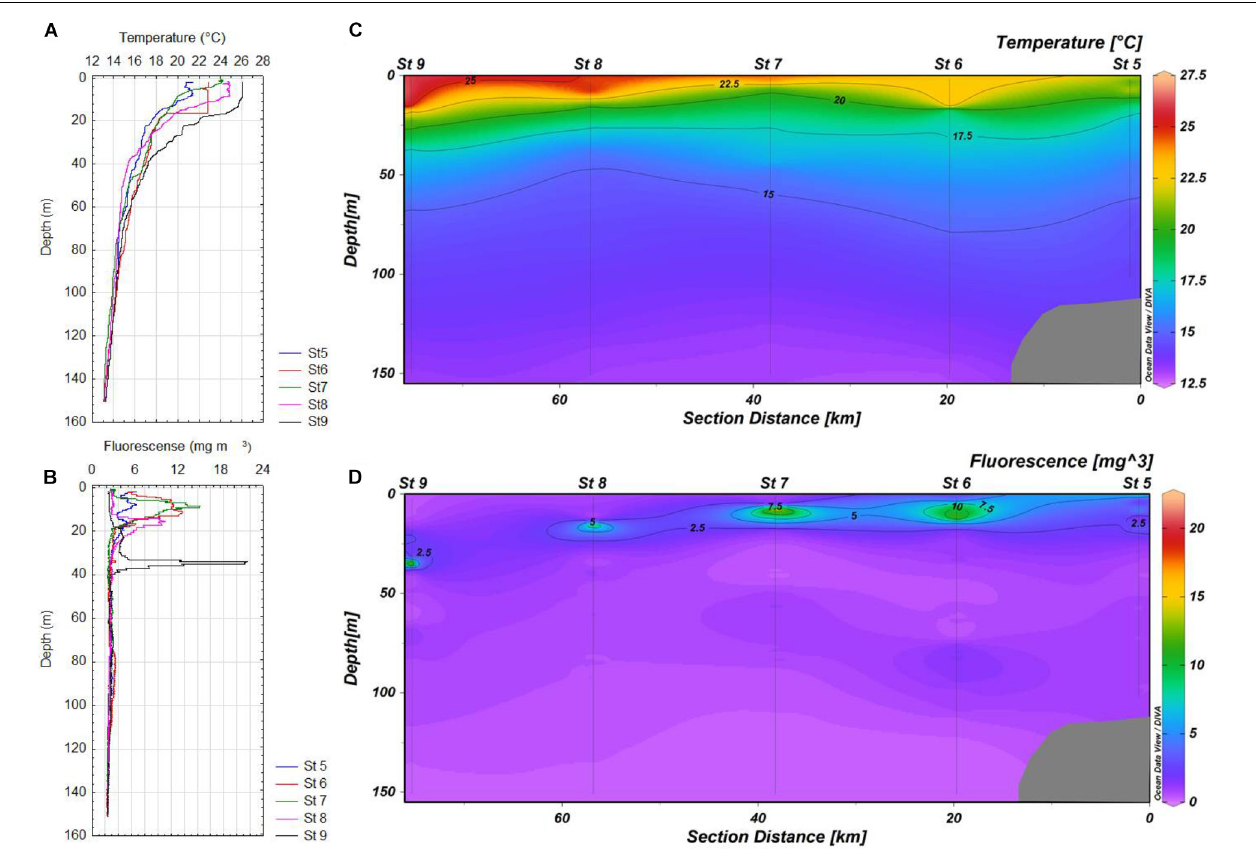
FIGURE 2 | (A,B) Vertical profiles of temperature and in situ fluorescence for stations 5-9 of the transect in Cabo Corrientes, respectively. (C,D) Maps of the distribution of temperature and in situ fluorescence for stations 5-9 in Cabo Corrientes,